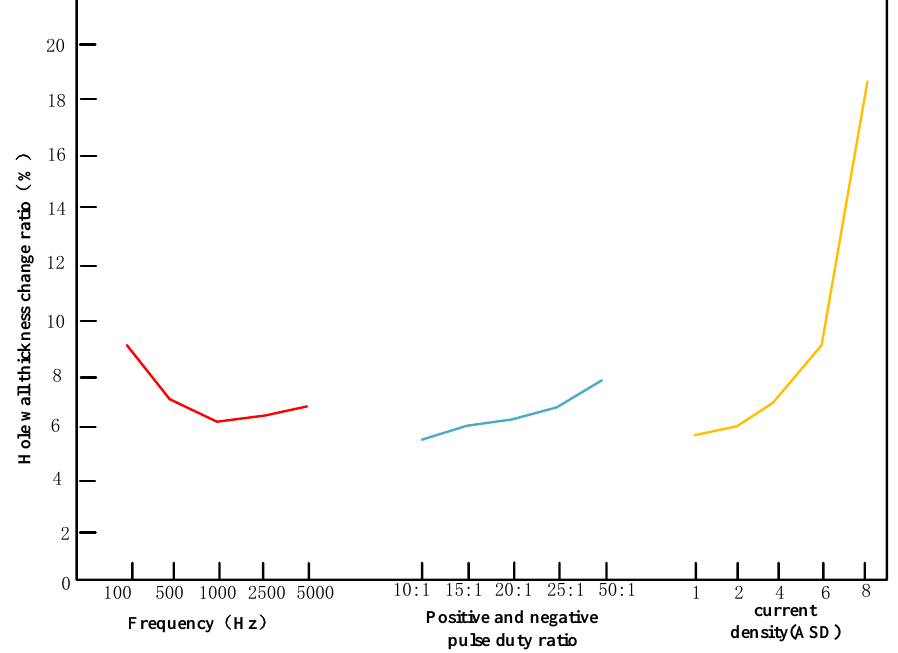
Figure 11. Relationship between pulse plating parameters and hole wall thickness.